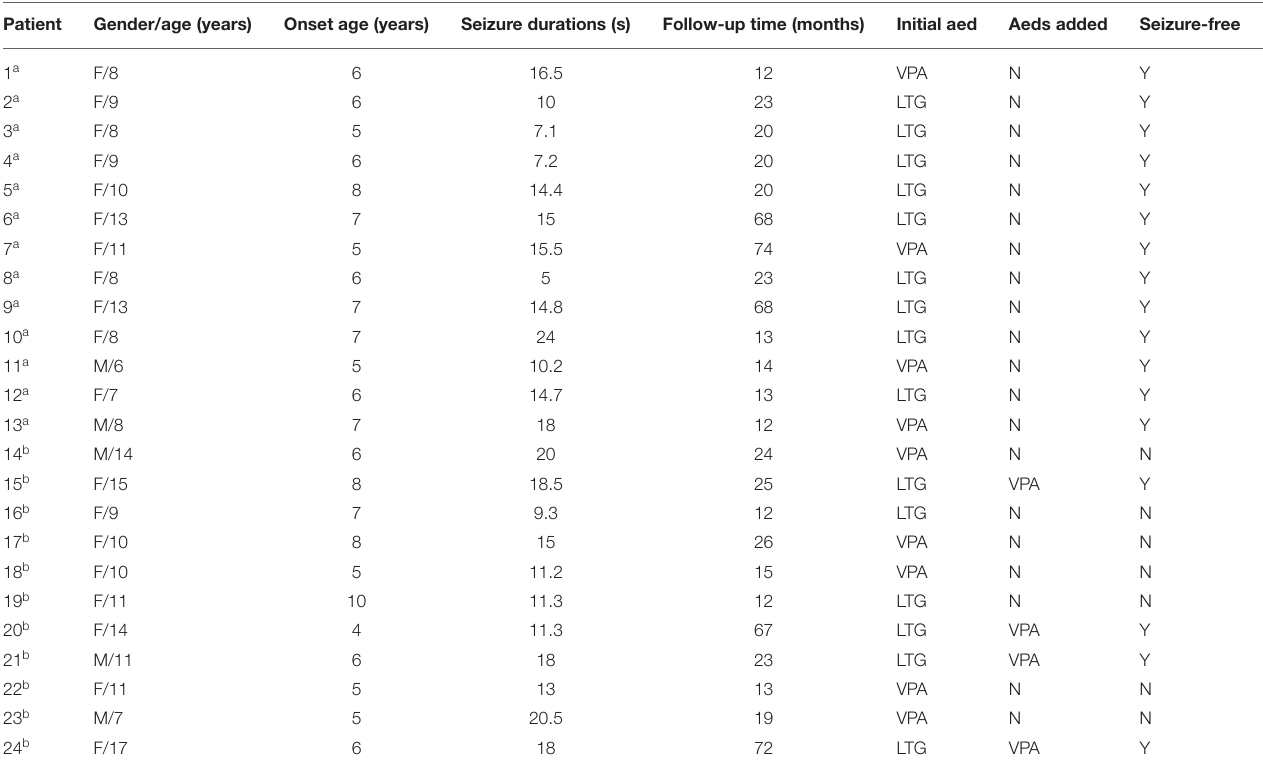
TABLE 1 | Characteristics of the